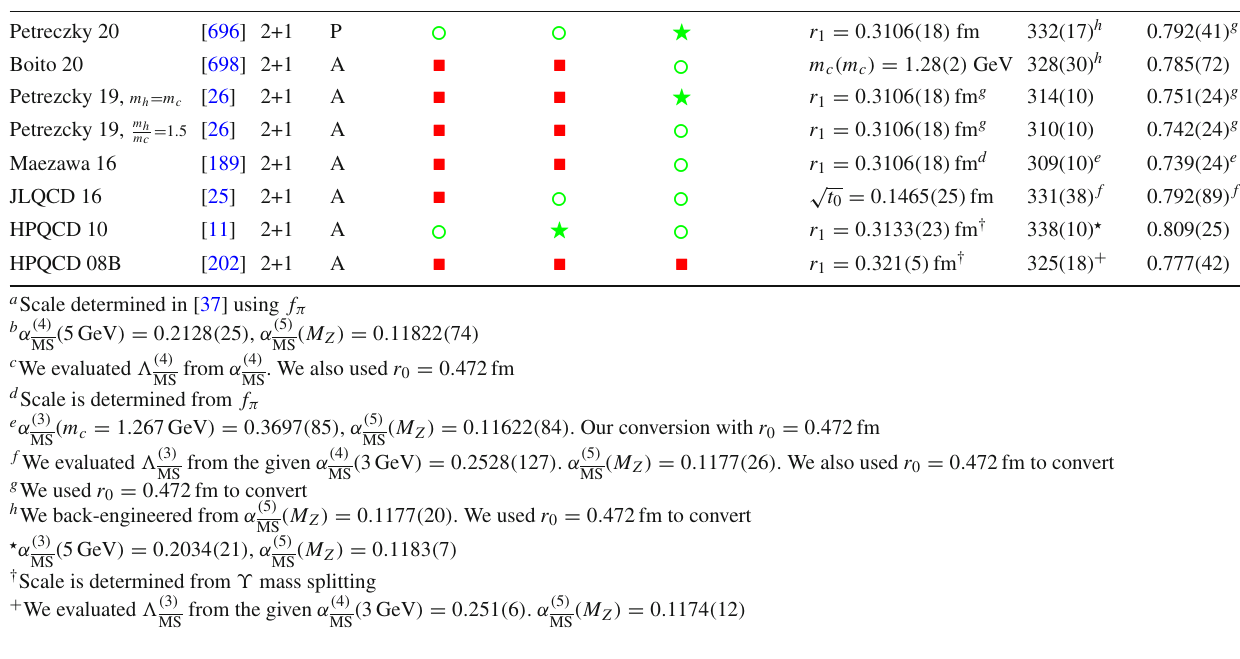
Table 64 Heavy-quark current two-point function results. Note that all analysis using 2 + 1 flavour simulations perturbatively add a dynamical charm quark. Partially they then quote results in N f = 4-flavour QCD, which we converted back to N f = 3, corresponding to the nonperturbative sea quark content